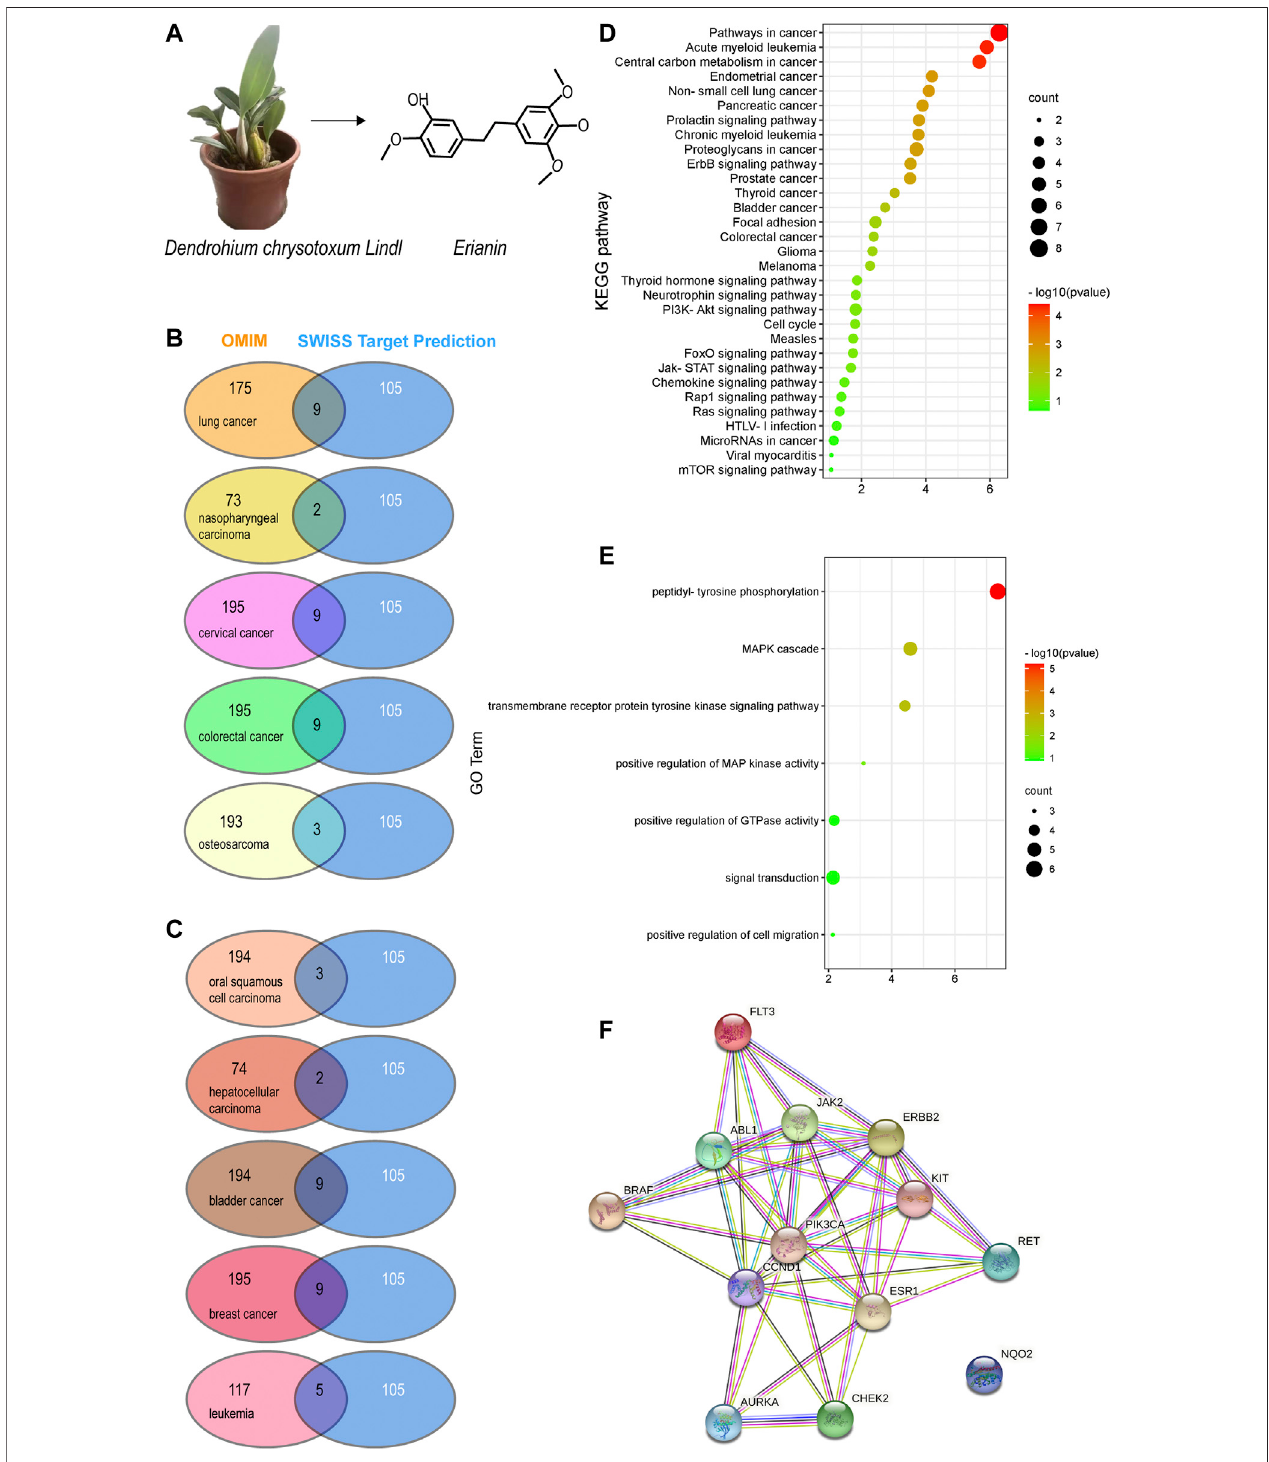
FIGURE 1 | Potential target prediction and analysis of the KEGG pathway, GO_BP, and target – target interaction. (A) Molecular structure of erianin; (B – C) overlapping target analysis by Venn diagrams; (D) KEGG pathway enrichment of the overlapping targets; (E) GO_biological process analysis of the overlapping targets; (F) target – target interaction of the overlapping targets analyzed by STRING.